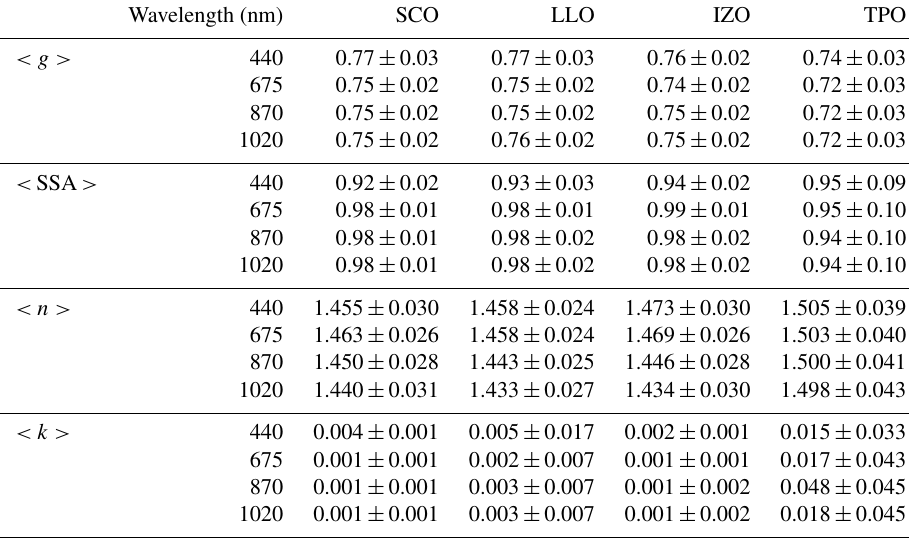
Table 1. Annual mean values at 440, 675, 870 and 1020nm of the aerosol properties g (the asymmetry parameter), SSA (the simple scattering albedo) and n and k (the values of the real and imaginary parts of the refractive index, respectively) at SCO, LLO, IZO and TPO, including the standard deviation.